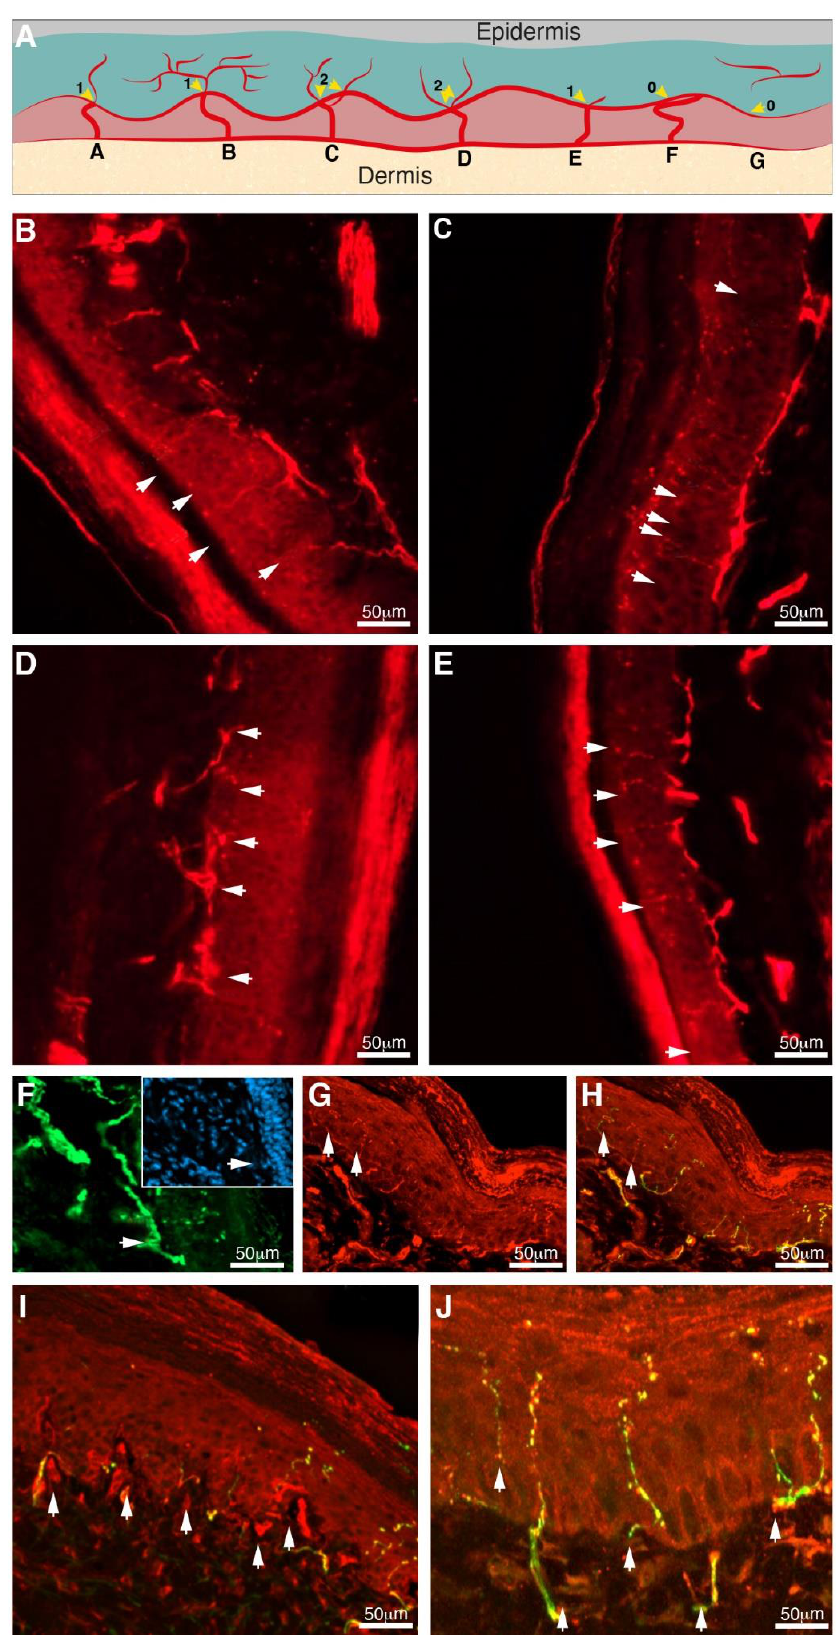
Figure 3. A schematic diagram depicting the intra-epidermal nerve fiber (IENF) counting rules and immunohistochemistry photos of punch biopsies of the different experimental groups. ( A ) Dia-